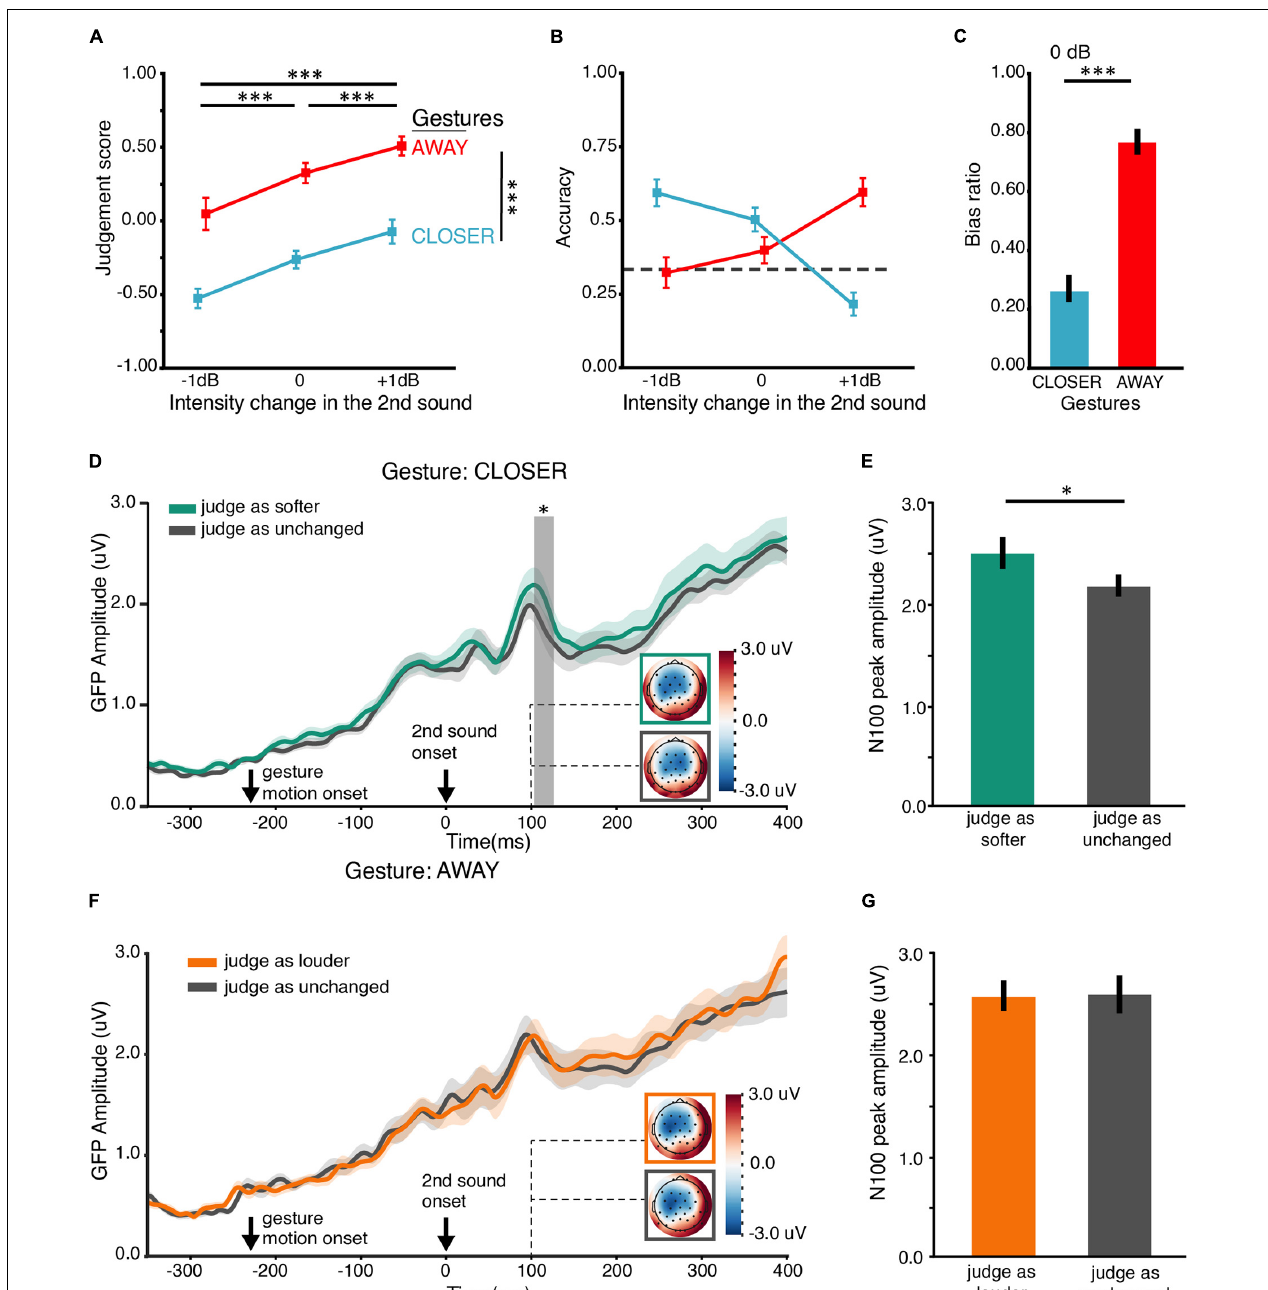
FIGURE 5 | Results of EE2. (A) Judgment score. Behaviorally, both gesture and intensity change positively affect the judgment of loudness changes, like the results in BE1 in Figure 2A . (B) Accuracy of the behavioral judgment about intensity change. An interaction between the factors of gesture and intensity change was observed, consistent with the results in BE1 ( Figure 2B ). The interaction was driven by the boost of accuracy by the CLOSER gesture in –1-dB intensity change and by the AWAY gesture in the +1-dB intensity change. (C) Bias ratios in the 0 dB intensity change conditions. The bias ratio was calculated as the judgment biased toward a louder percept: bias ratio = frequency of louder bias/frequency of all bias. AWAY biased participants toward choosing louder (higher bias ratio) while CLOSER biased participants toward choosing softer (lower bias ratio); the actual intensity did not change. (D) ERP responses to the second sound with 0-dB intensity change in the CLOSER conditions as a function of loudness perception. Stronger ERP responses were observed at around 115-ms latency when the second sound was perceived as “softer” (green) than was perceived as unchanged (gray), although the stimuli were the same sound of 0 dB intensity change. The solid lines indicate the grand mean global field power (GFP) waveforms. The shades around the solid lines represent ± one SEM. Response topographies are shown in colored boxes with dashed lines pointing to their latencies. The colored boxes use the same color schemes as the waveform responses to indicate different conditions. The gray vertical shades indicate the temporal cluster (104–207 ms) in which the two GFPs were significantly different in the temporal cluster analysis.